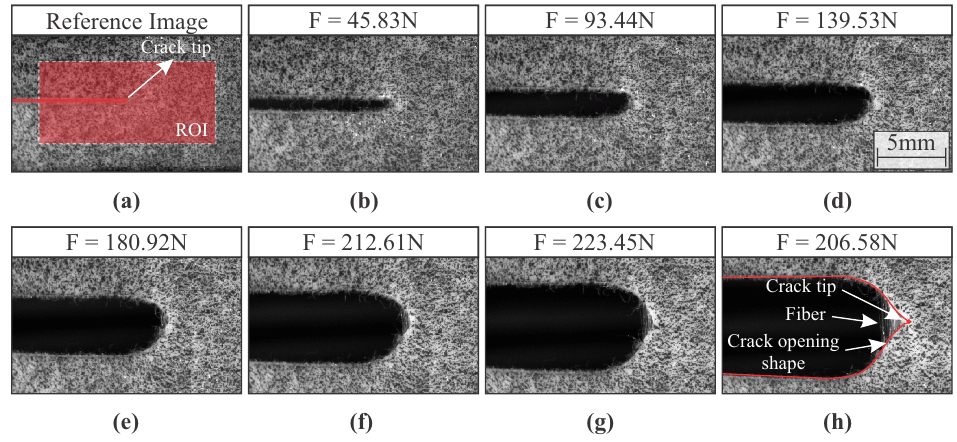
Figure 6. Crack growth in a fibrous hyperelastic soft composite with fibers oriented at 0 ◦ : ( a ) un- deformed state with depicted Region of Interest (ROI); ( b ) deformed states with applied loads of 45.83 N; ( c ) 93.44 N; ( d ) 139.53 N; ( e ) 180.92 N; ( f ) 212.61 N; ( g ) 223.45 N; ( h ) 206.58 N.